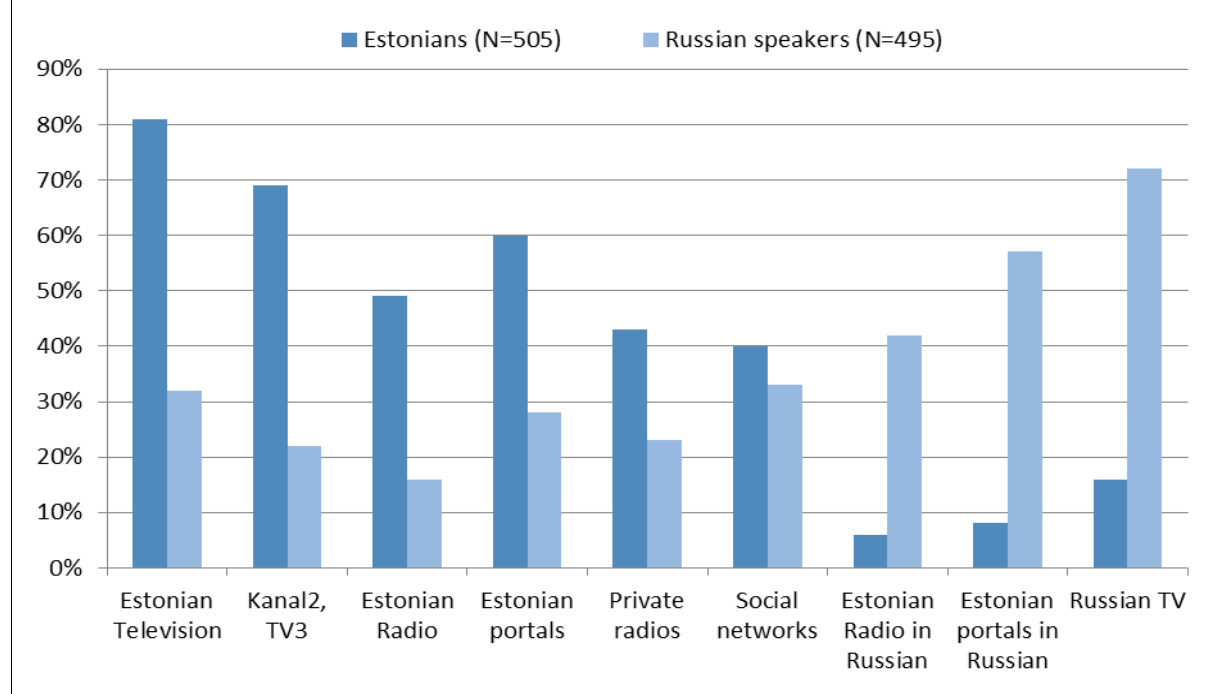
Figure 2. Importance of the media channels among Estonians and Russian speakers. Source: Author’s calculation based on Saar Poll